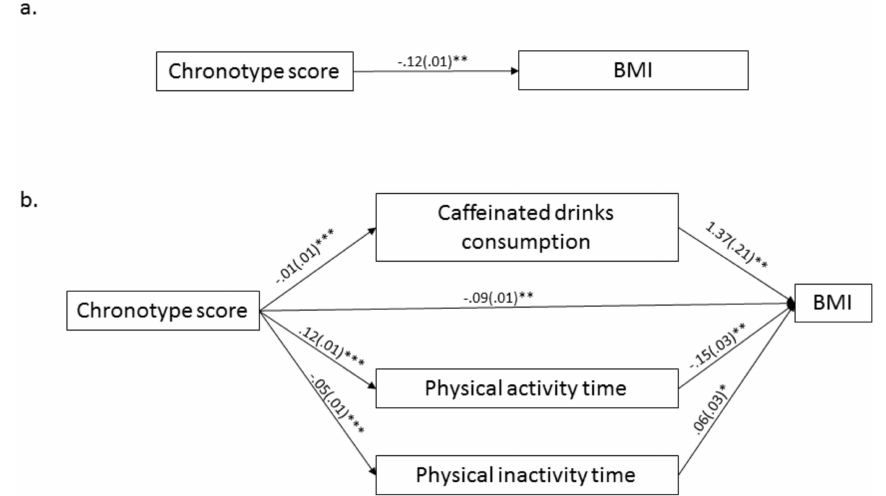
Figure 1. Primary multiple mediation model between chronotype scores and BMI